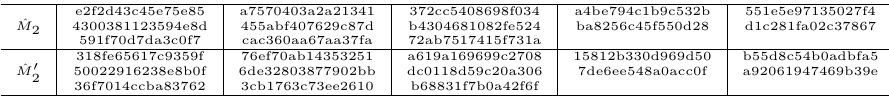
Table 7: Suffix Seed Pair for Semi-free 4-bit Internal Collision